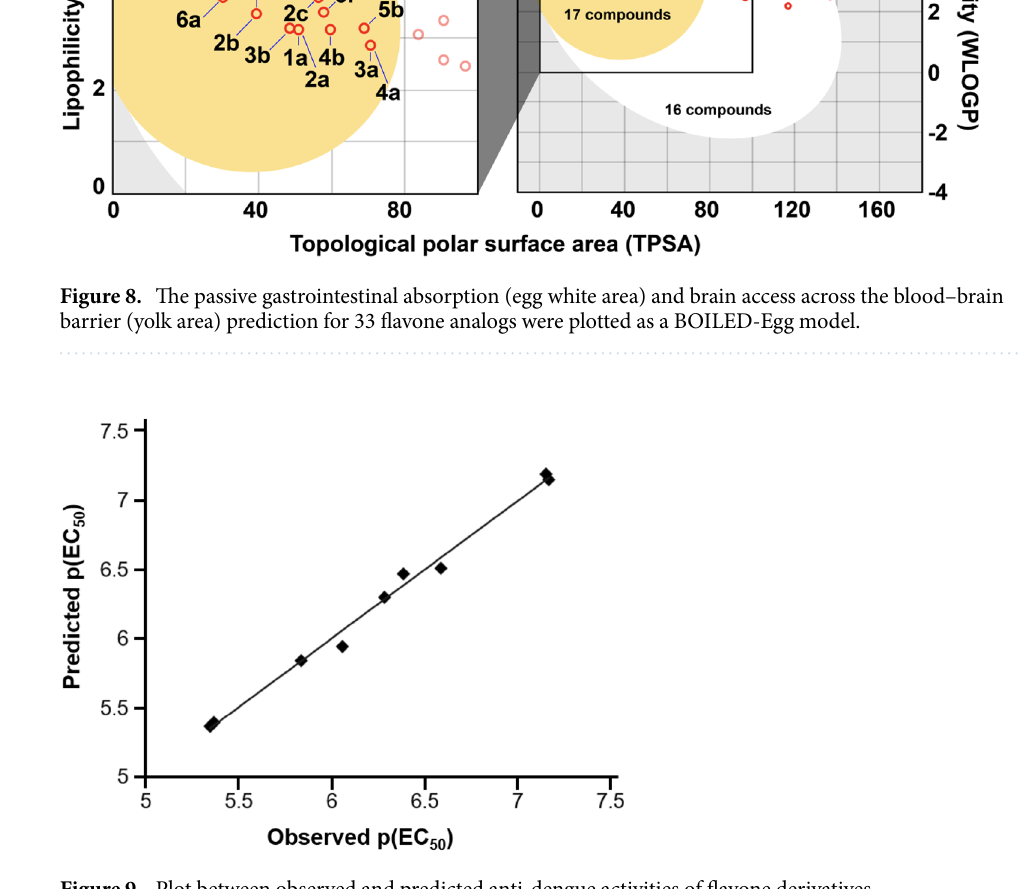
Figure 9. Plot between observed and predicted anti-dengue activities of flavone